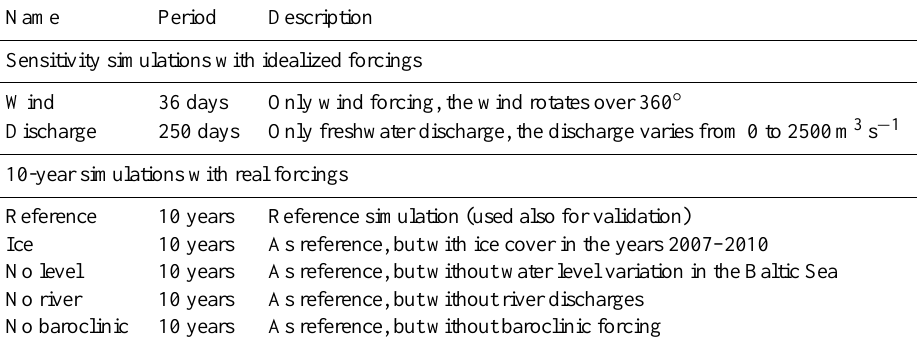
Table 1. Summary of simulations carried out. The first two simulations are idealized simulations to investigate the exchange capabilities depending on wind and river discharge. The other simulations are simulations with real forcings. Name Period Description Sensitivity simulations with idealized